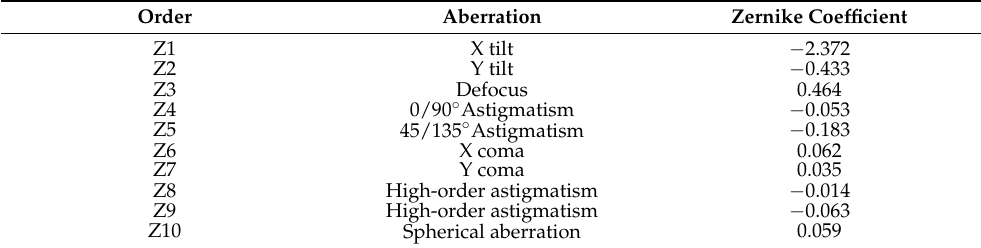
Table 2. The definition and weight value of the first 10 Zernike aberration